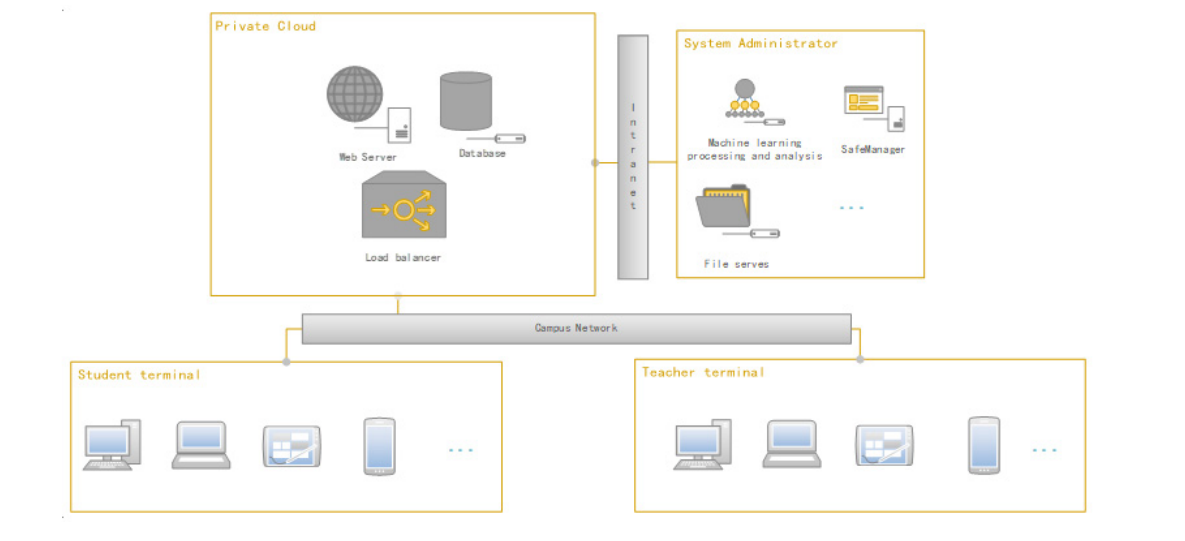
Figure 1. The Architecture of TFCAS.